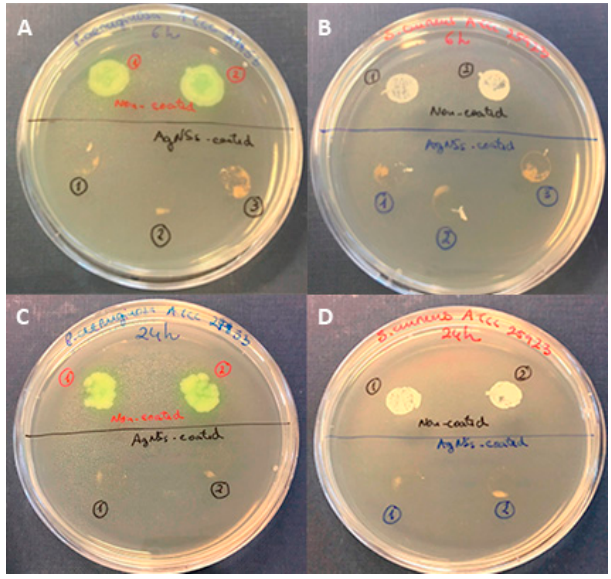
Figure 2. Comparison of the biocidal/killing effects of AgNSs-coated surfaces versus the non-killing effect of AgNSs non-coated surfaces against P. aeruginosa ATCC 27853 ( A , C ) and against S. aureus ATCC 25923 ( B , D ) after 6 h ( A , B ) or 24 h ( C , D ) of contact of the inoculated bacteria with the surface, at 37 °C in the dark.